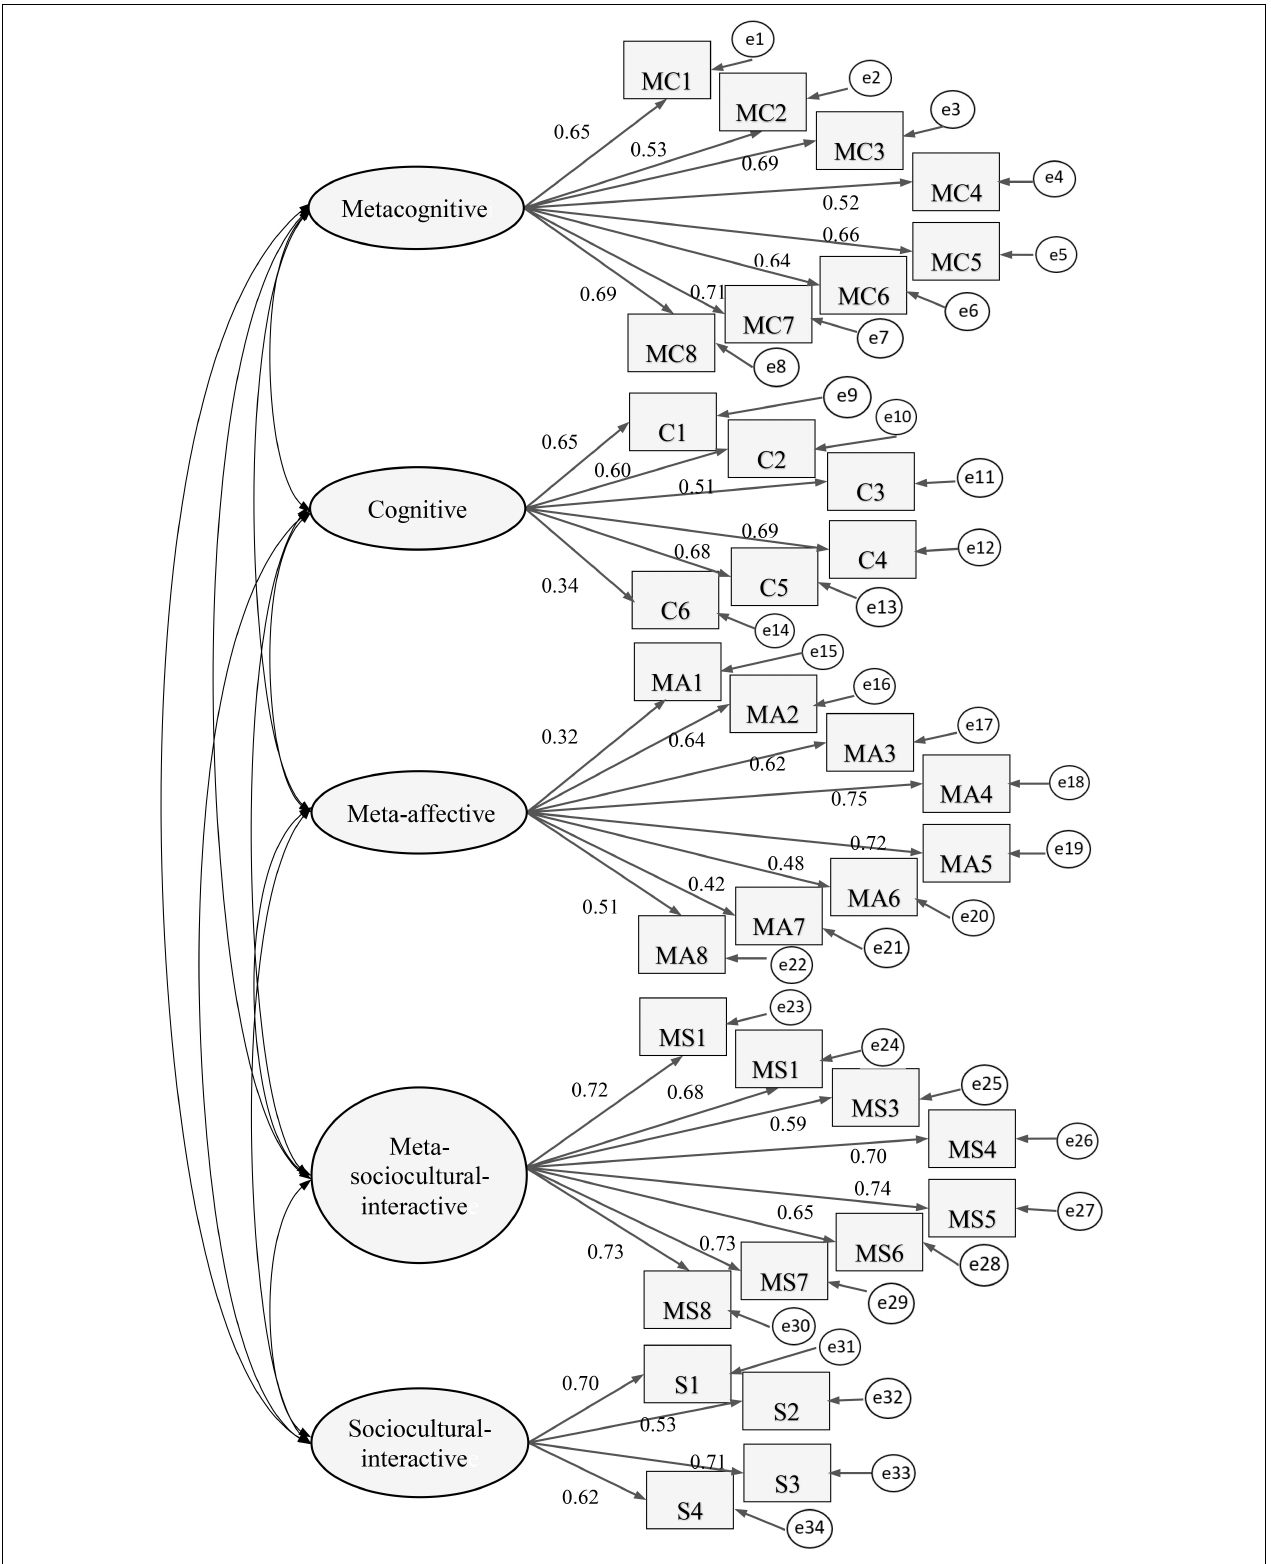
FIGURE 2 | The five-factor structural model of the SRFLLSQ, displaying latent and observed variables and measurement errors ( N = 2223).